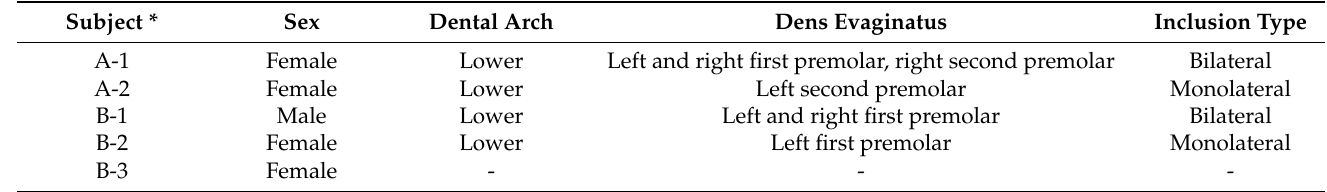
Table 1. Clinical characteristics of patients with dens evaginatus from Families A and B.